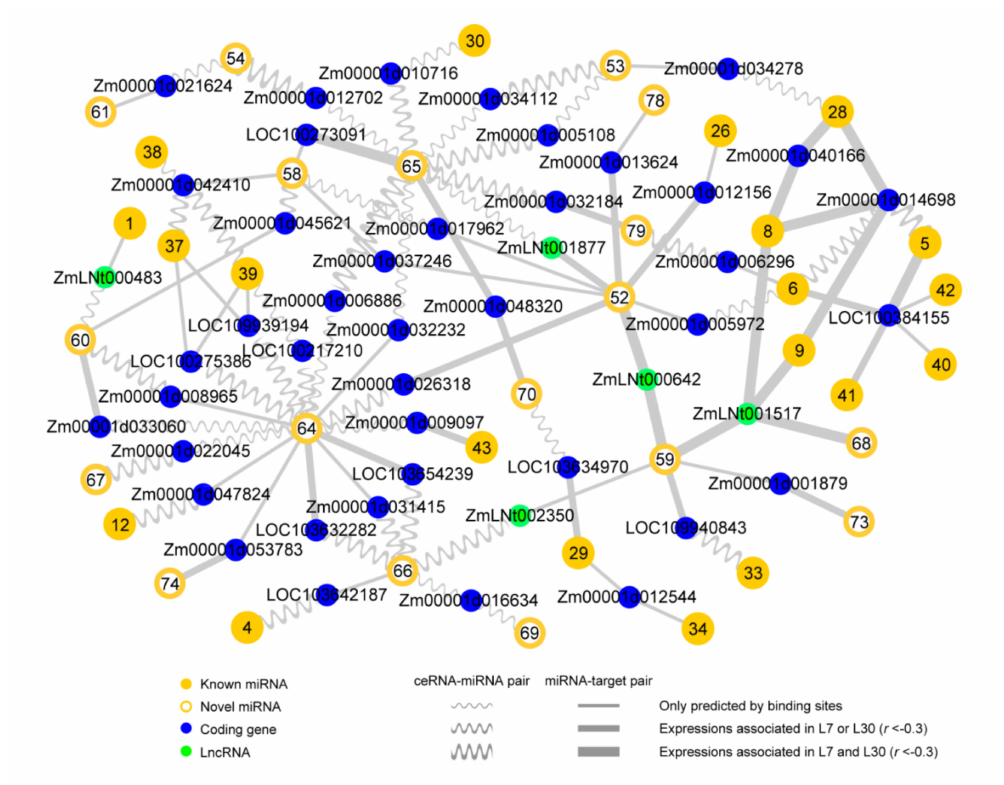
Figure 5. The complex crosstalk among the 38 reconstructed ceRNA-miRNA-target gene regulatory networks. Numbers in the yellow dots and circles represent 20 known miRNAs and 18 potentially novel miRNAs respectively, that are numbered in Figure